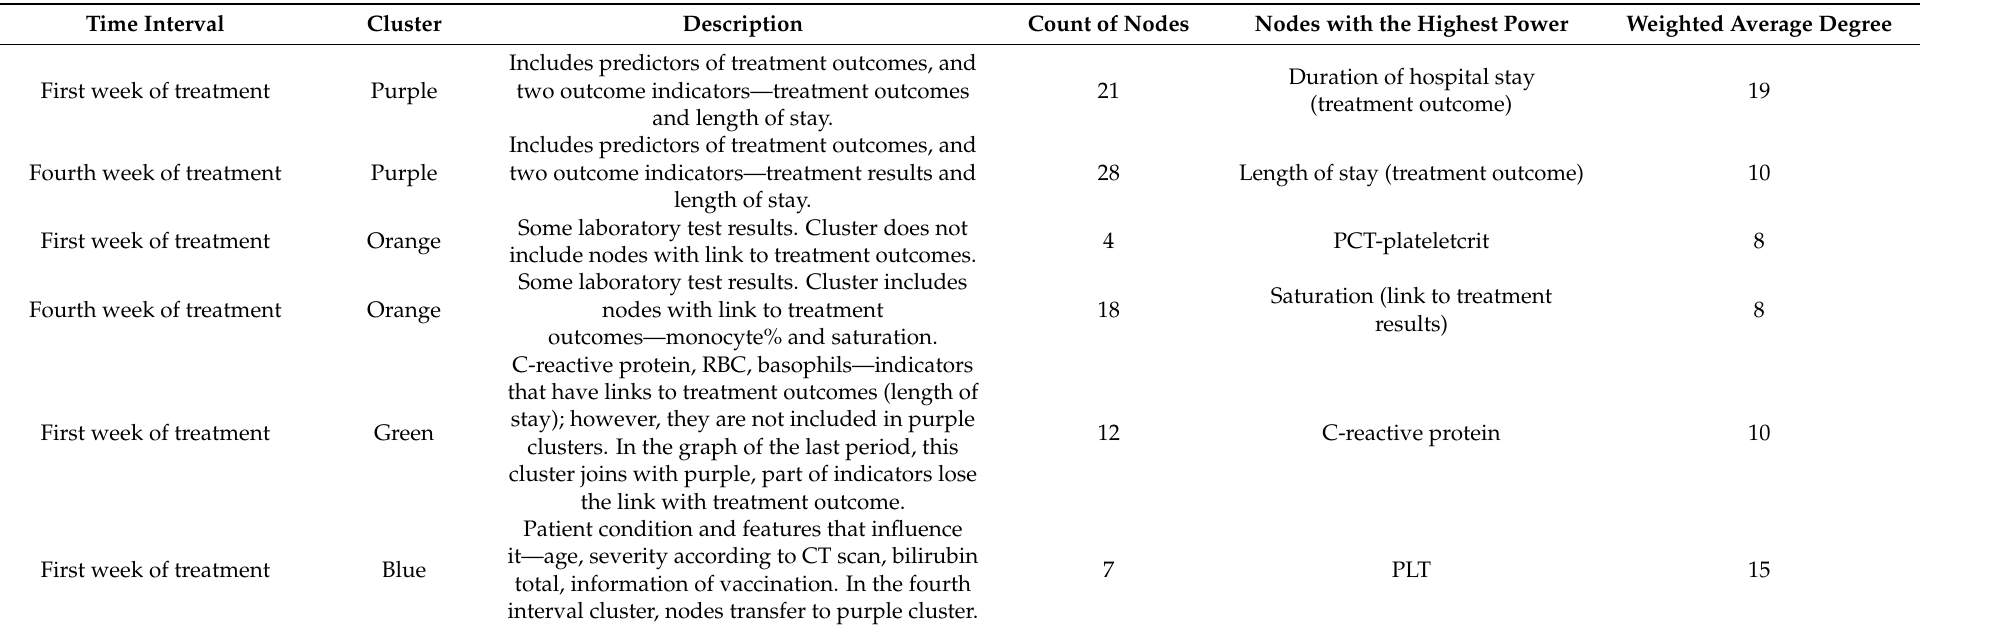
Table 3. Description of the resulting network for the first-time